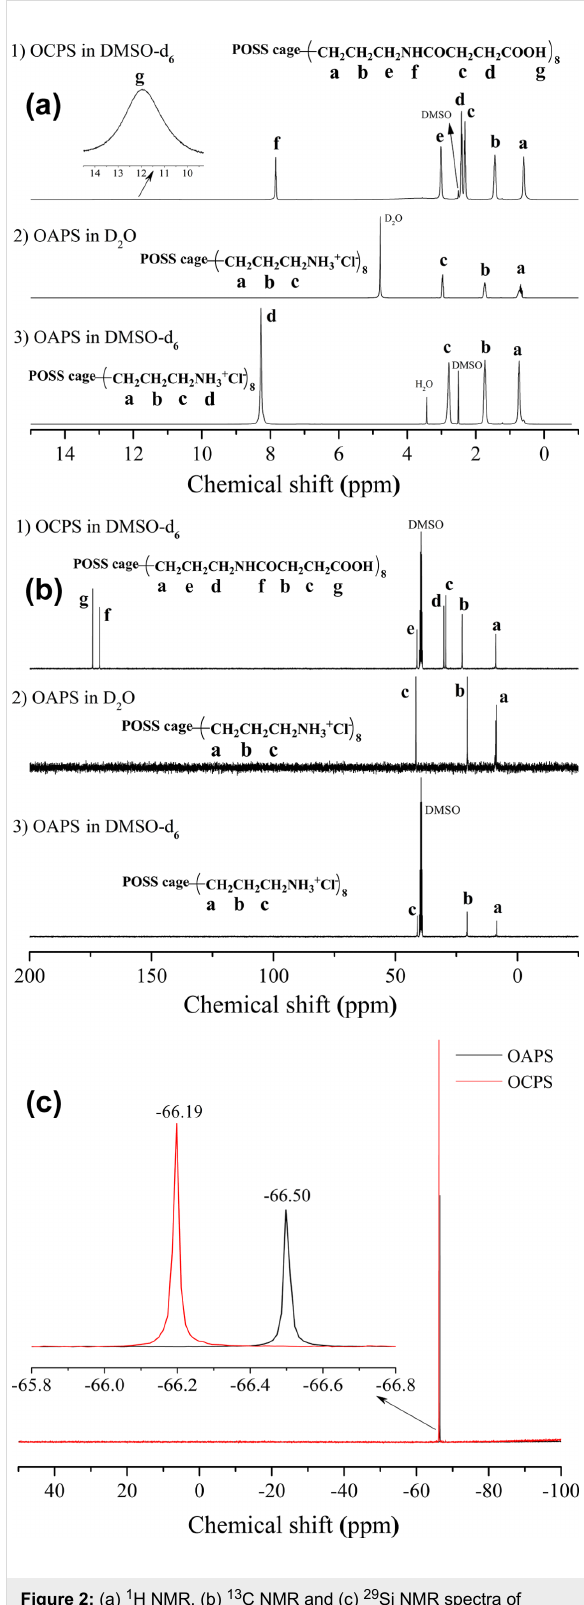
Figure 2: (a) 1 H NMR, (b) 13 C NMR and (c) 29 Si NMR spectra of OAPS and